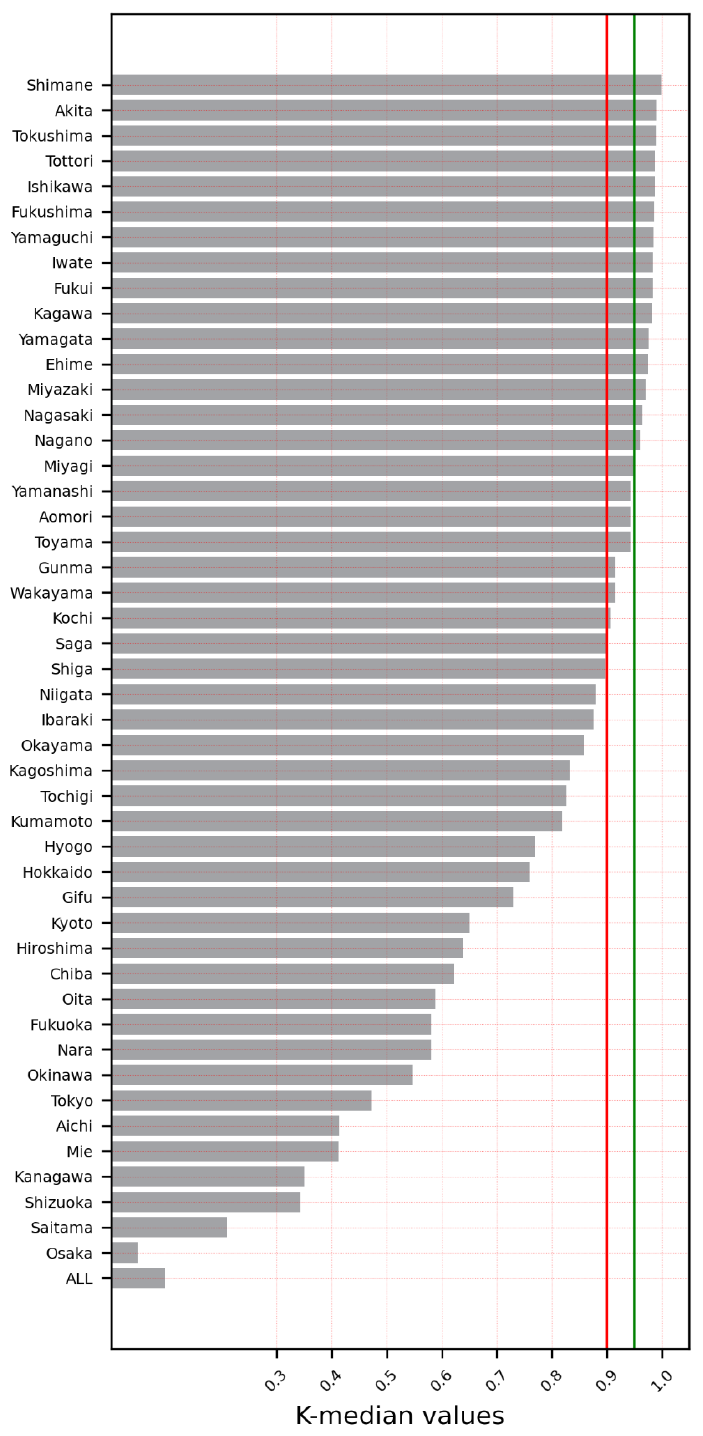
Figure 7. K-median values for all prefectures including the entire country for data until 8 October 2021.